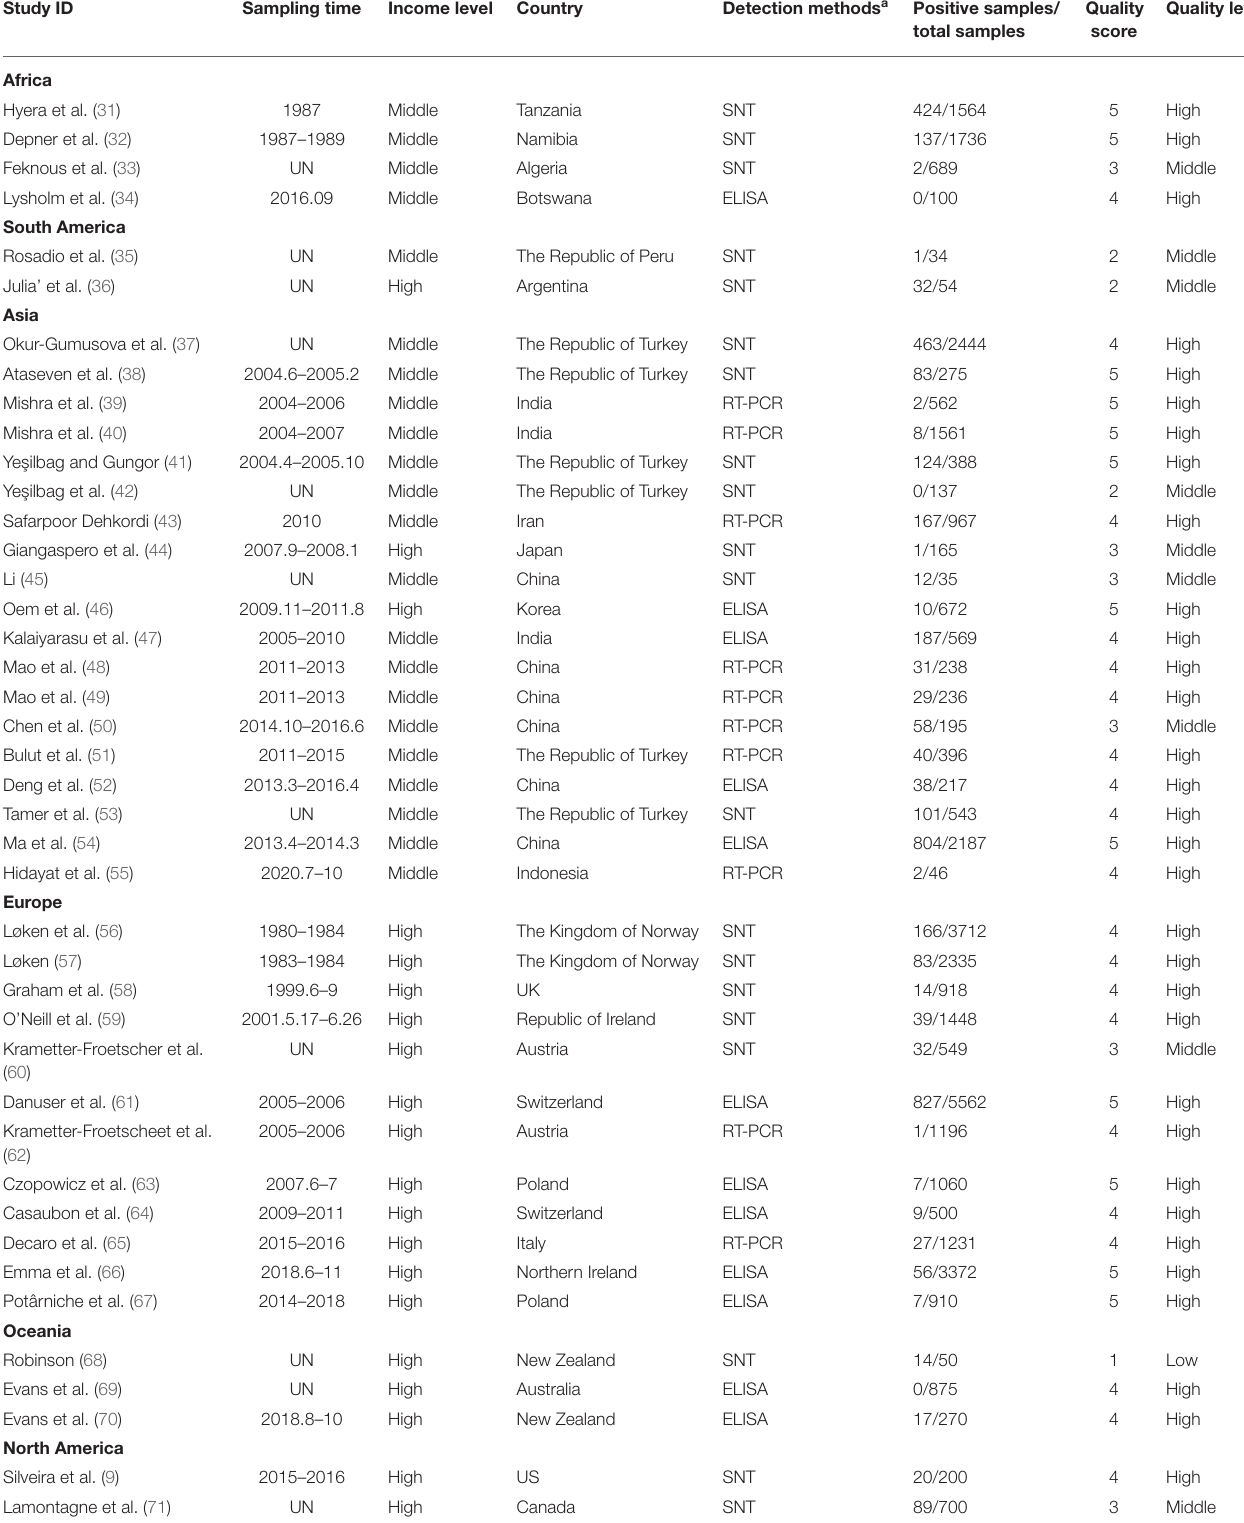
TABLE 1 | Included studies of BVDV infection in sheep and goats